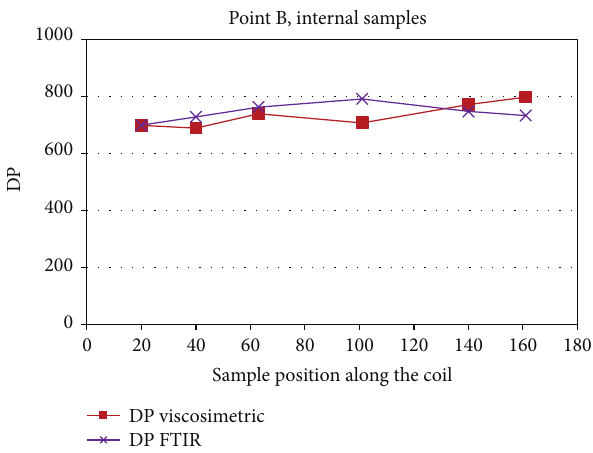
Figure 7: DP measurements of samples on point B of the trans- former